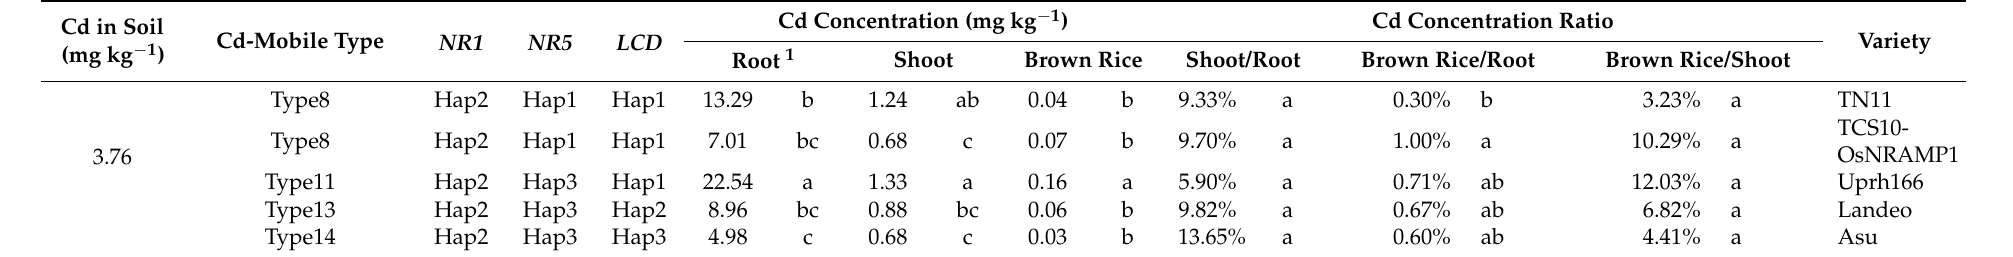
Table 2. The Cd concentrations for representative varieties of five Cd-mobile types tested in pot